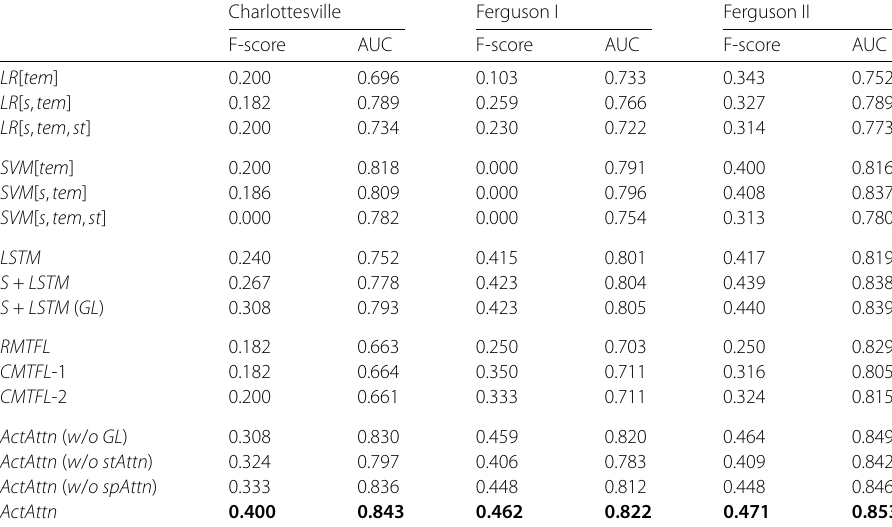
Table 2 Forecasting